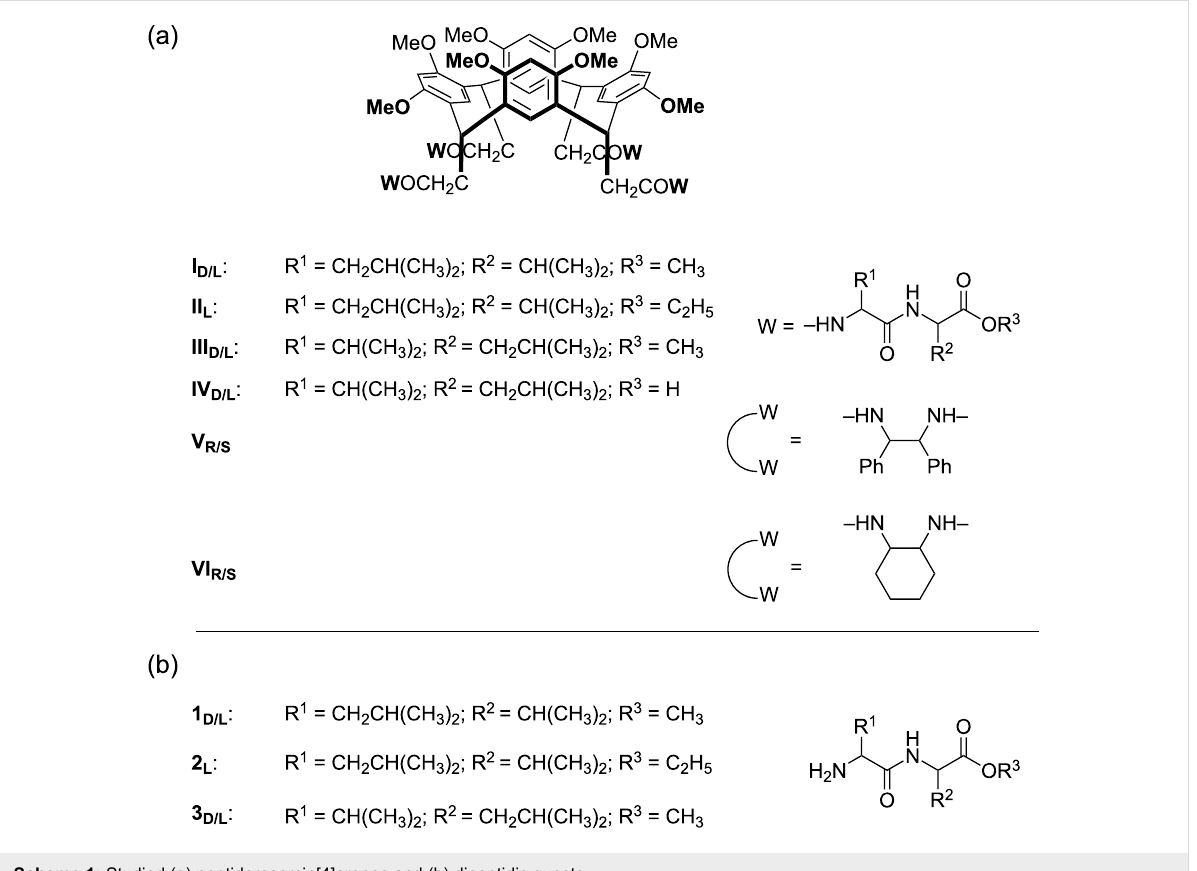
Scheme 1: Studied (a) peptidoresorcin[4]arenes and (b) dipeptidic guests.